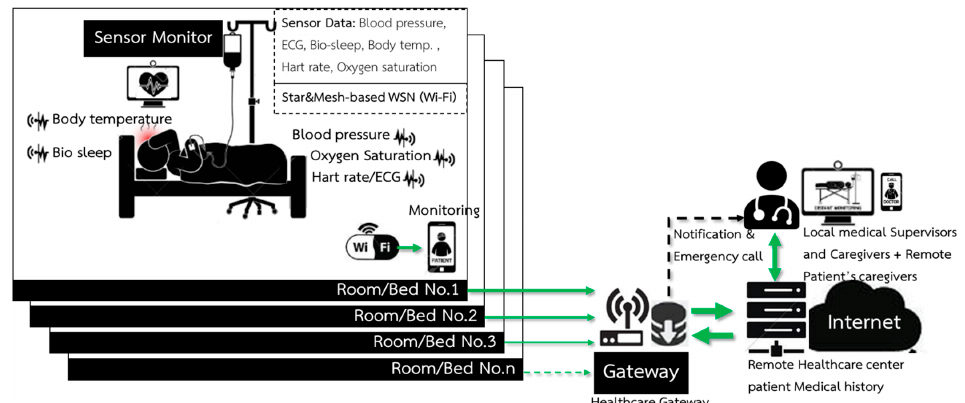
Figure 4. The intelligent wireless network system for monitoring the vital signs of internal patients.